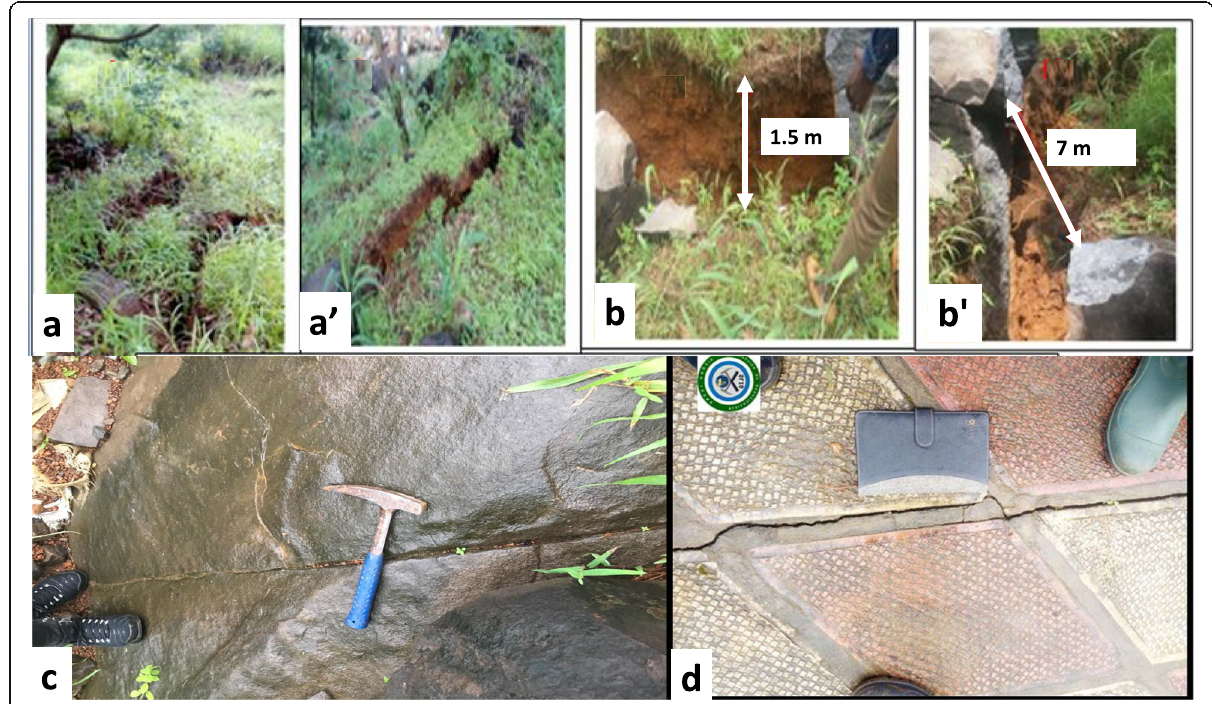
Fig. 9 Lineaments away from the main body of Madina landslide ( a - a ’ ) tension cracks with varying widths in the north-west and adjacent to landslide; ( b - b ’ ) major fracture zone with displaced rock fragments; ( c ) open joint on rock exposure adjacent Madina landslide area; ( d ) cracks on the floor of the building-35m away from the epicenter of the landslide (Sillah et al., 2019)